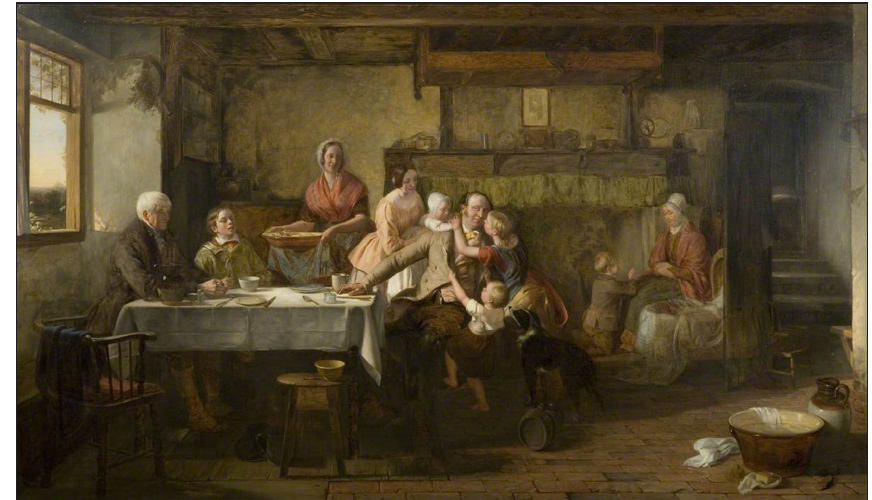
Fig. 5 : Thomas Webster, Good Night , 1846, oil on panel, 71.4 × 118.7 cm, Bristol Museums and Art